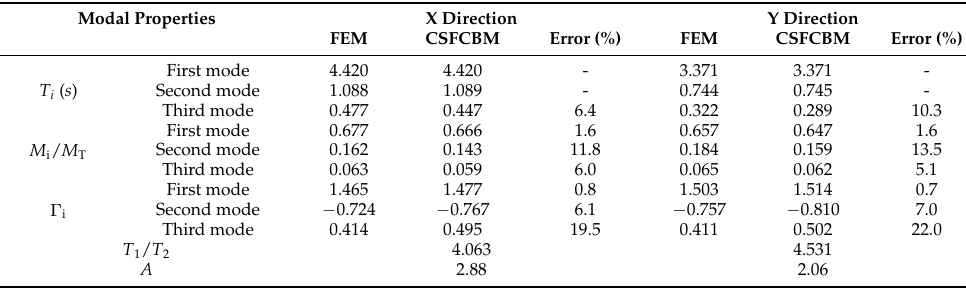
Table 2. Modal properties of building S1.